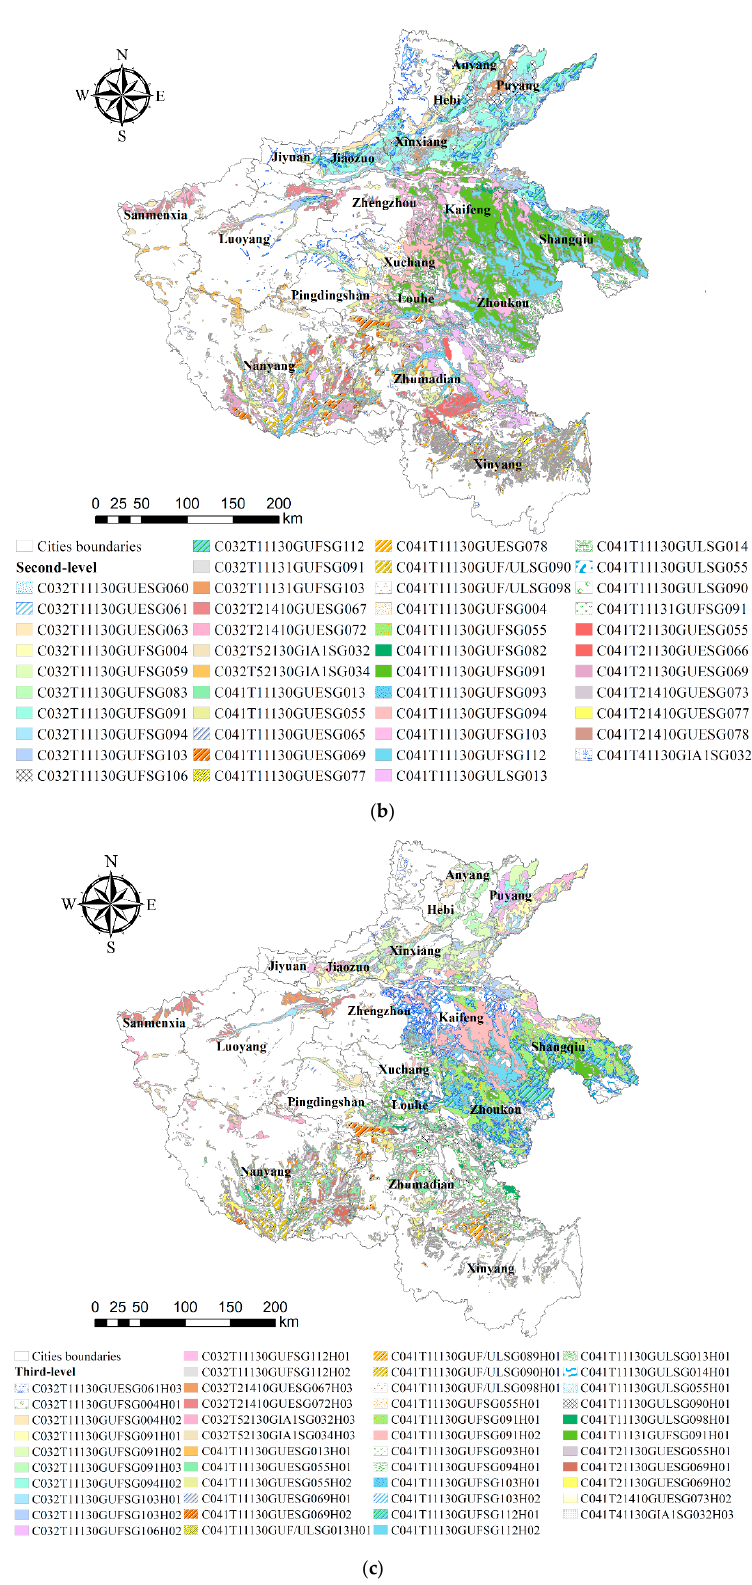
Figure 5. Distribution map of land types in Henan province. ( a ) Distribution map of first-level types, ( b ) distribution map of second-level types (top 45 by area proportion), and ( c ) distribution map of third-level types (top 45 by area proportion).